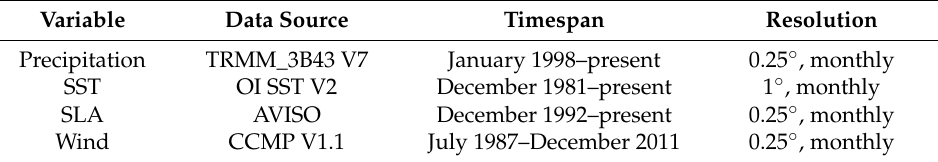
Table 1. The sources, timespans, and spatial and temporal resolutions of the